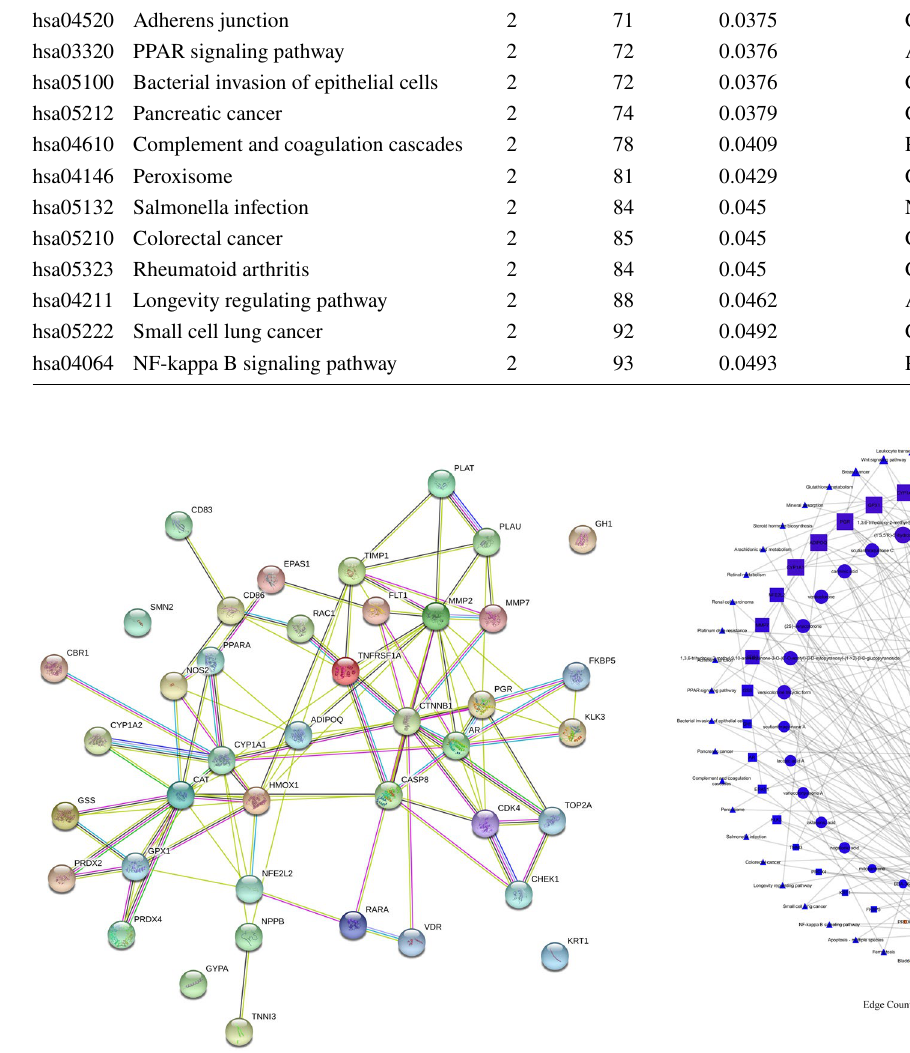
Fig. 2 Network interaction of anthraquinone derivatives with their proteins and regulated